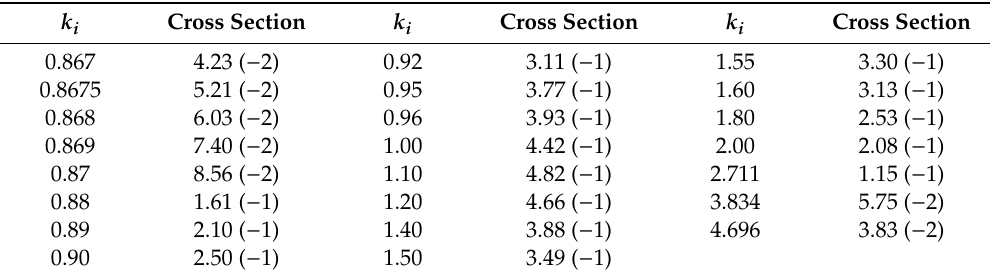
Table 3. 2 S excitation cross sections in the Born approximation.